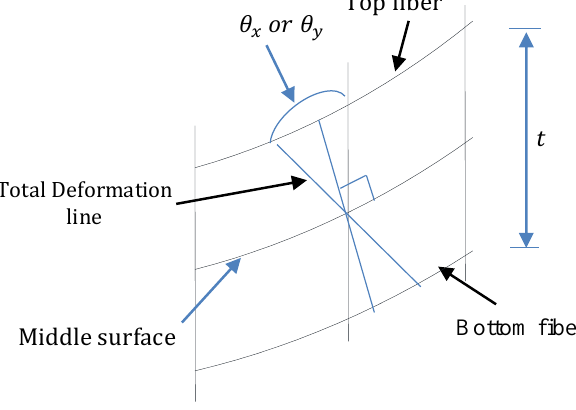
Figure 2. Rotation of x-z (or y-z) section after